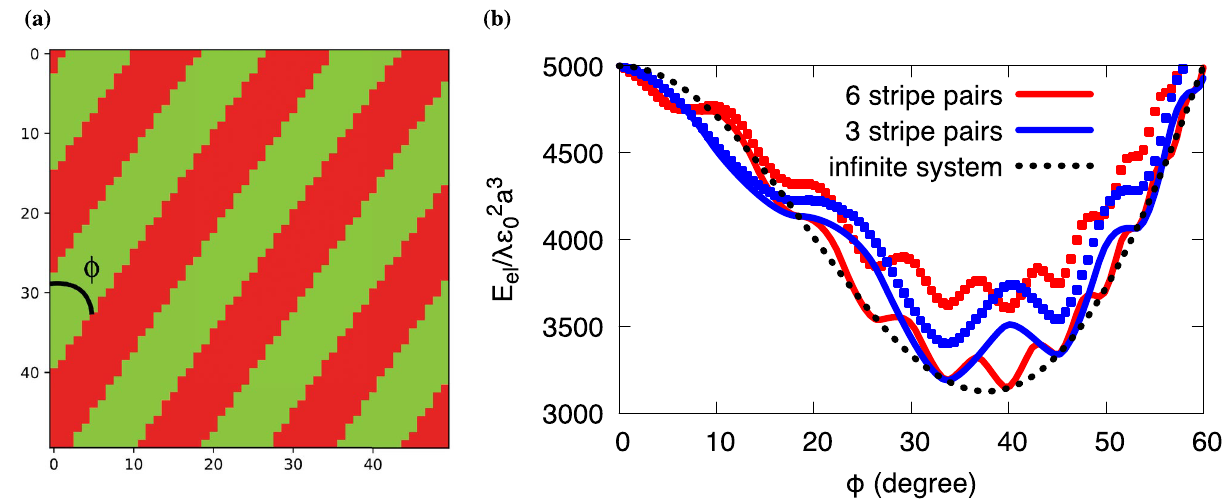
Figure 3. Resulting stripe patterns for tetragonal eigenstrain. ( a ) Equilibrium structure with three stripe pairs (counted along the horizontal axis) in a system consisting of 50 0 , is imposed. The width of the stripes is uniform, consisting of grains with configuration s ε ij � � = 1 (green). ( b ) Elastic energy of stripe patterns with different inclination angles φ . The solid curves and s i = − correspond to smooth stripes (the grain size a / L x , a / L y point for inclinations for which the pattern repeats periodically without kinks at the boundaries. The squares correspond to situations with the same number of stripes, where the system is discretized by 50 grains, leading to pronounced aliasing effects, and the resulting elastic energy is higher than for the smooth stripes. This shifts the energetic minimum for 6 stripe pairs at φ pairs. The infinite system size limit for smooth stripes is depicted as black dotted